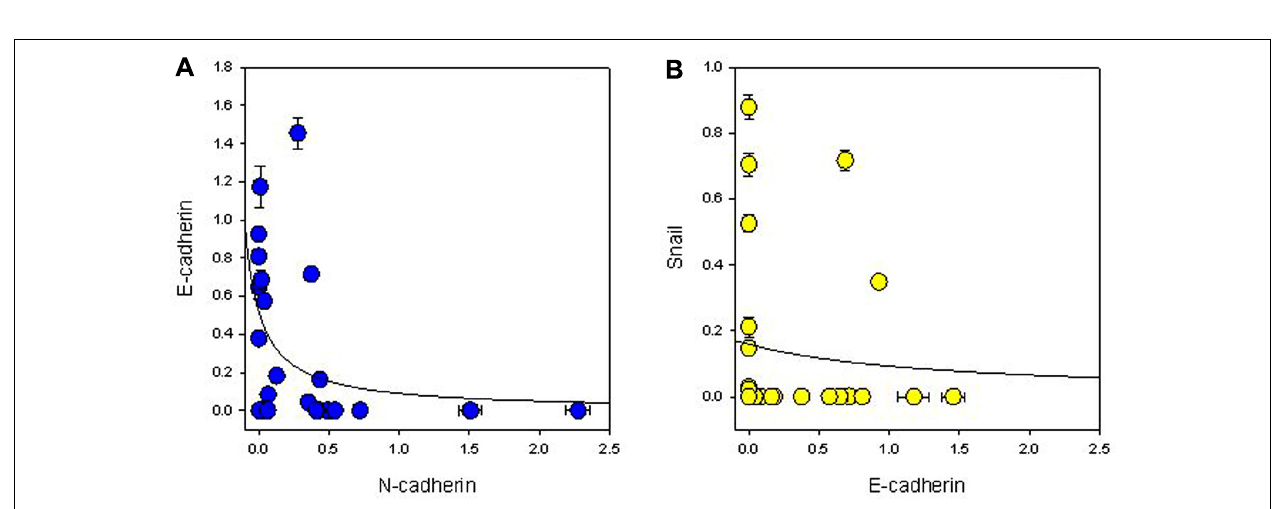
FIGURE 1 | (A) Western blots of whole-cell extracts derived from cultures of normal melanocytes and of a number of melanoma lines, indicating expression of N-cadherin, E-cadherin, Snail, and Slug.The numbers indicate the identities of members of the New Zealand melanoma collection (e.g.,